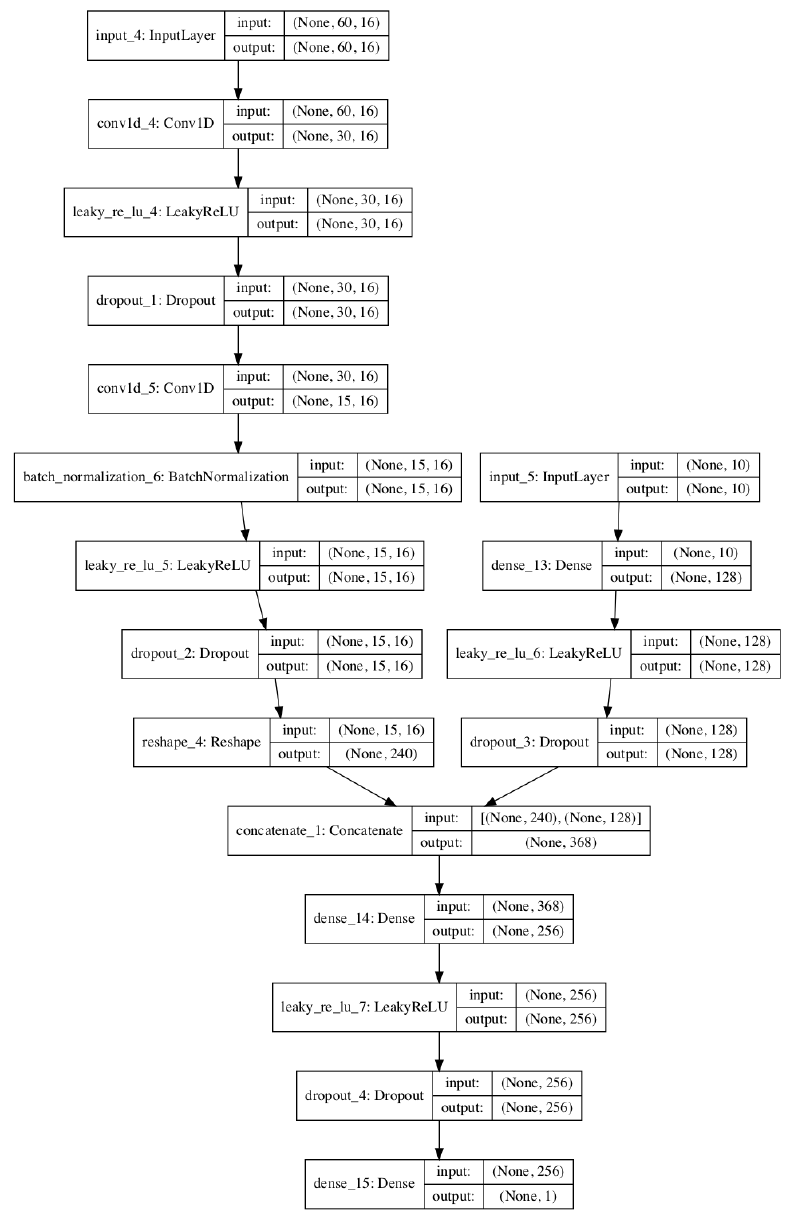
Figure A1. Network architecture of the discriminator in